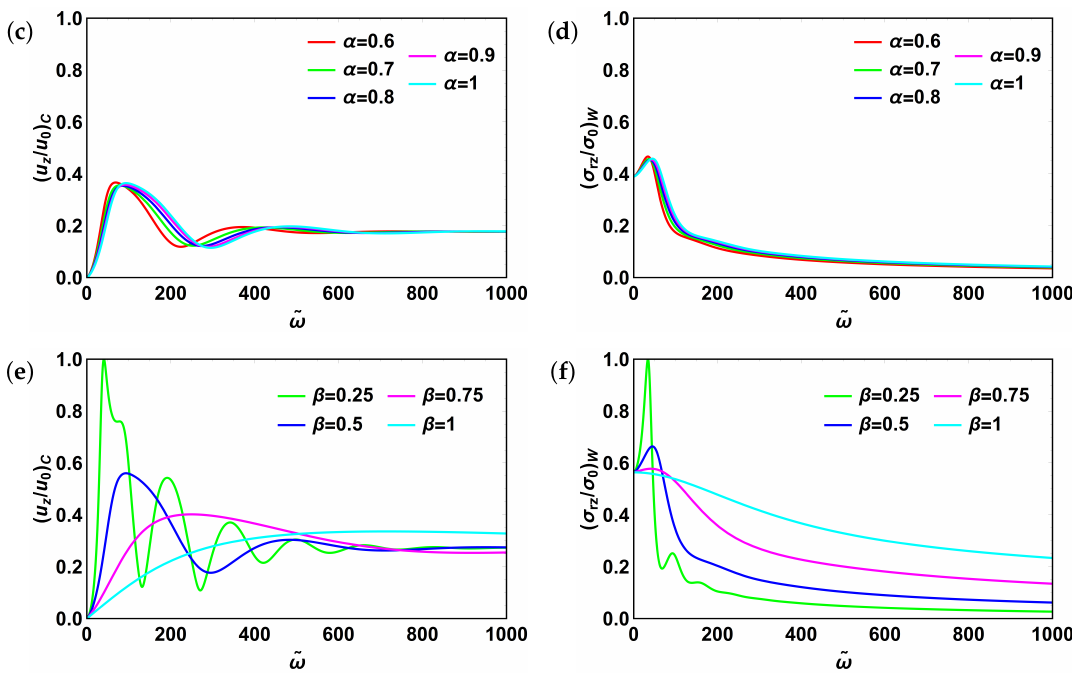
Figure 5. Fractional Maxwell model: ( a ) centerline velocity, α = 0.5; ( b ) shear stress, α = 0.5; ( c ) centerline velocity, β = 0.5; ( d ) shear stress, β = 0.5; ( e ) centerline velocity, α = 1; ( f ) shear stress, α = 1. For all plots ˜ a = 0.1. Subscripts “c” and “w” stand for “centerline” and “wall”, respectively.